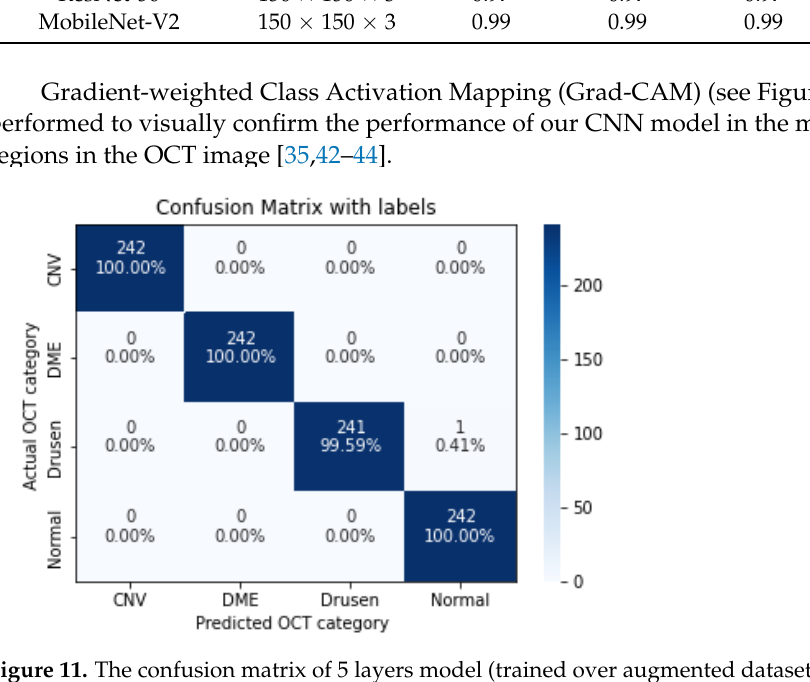
Figure 11. The confusion matrix of 5 layers model (trained over augmented dataset), with numbers and percentages.